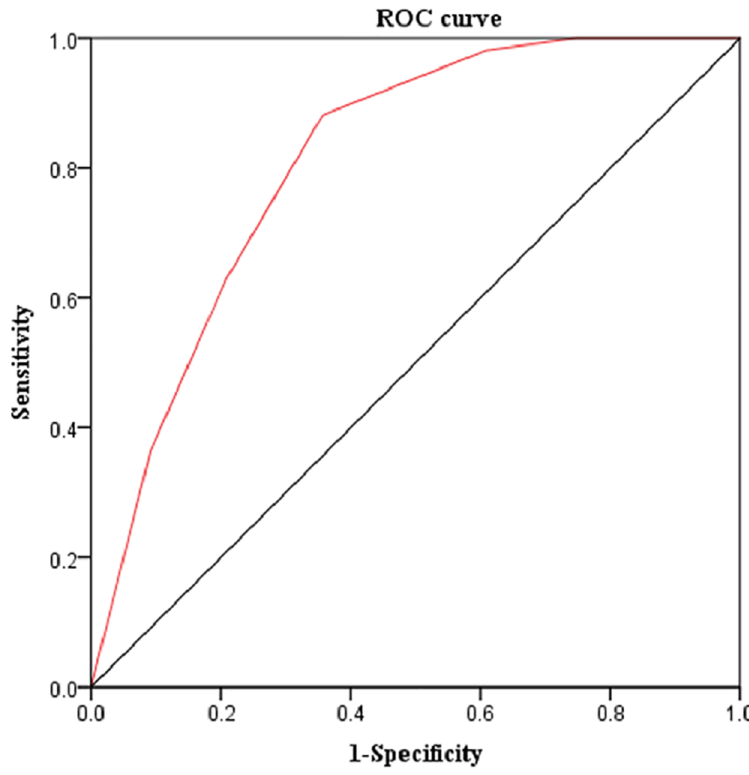
Fig 1. Receiver operating characteristics curve: Abilities of NVS-CHN to predict CCHLQ scores.